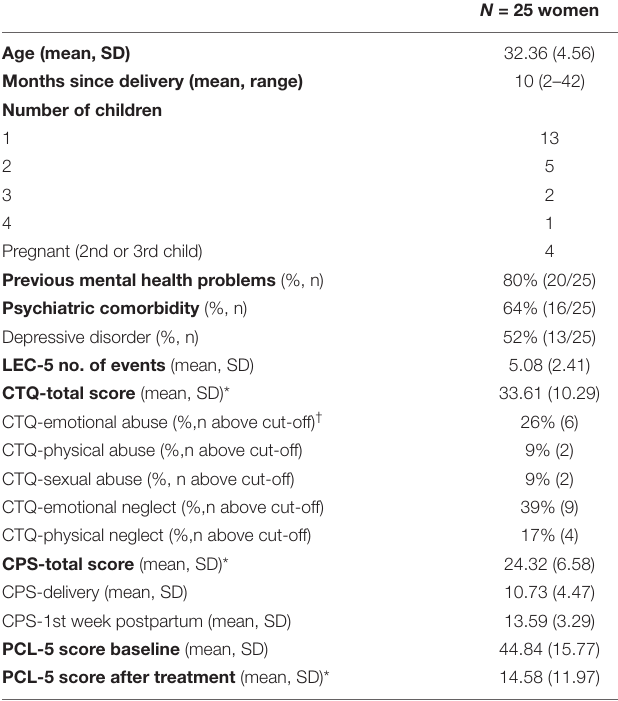
TABLE 1 | Respondent characteristics and main outcomes.